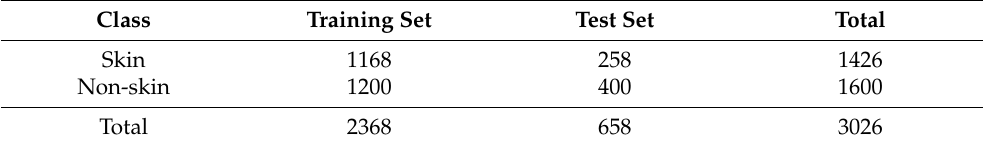
Table 2. Number of images per class in the final dataset for skin classification.